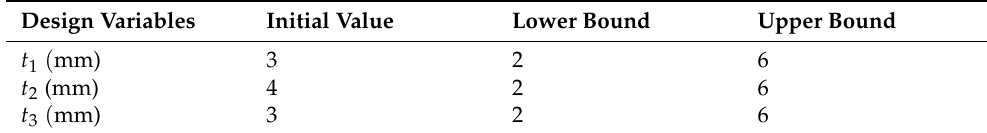
Figure 9. Design variables of SFE canister. Table 1. Initial value and range of design variables.